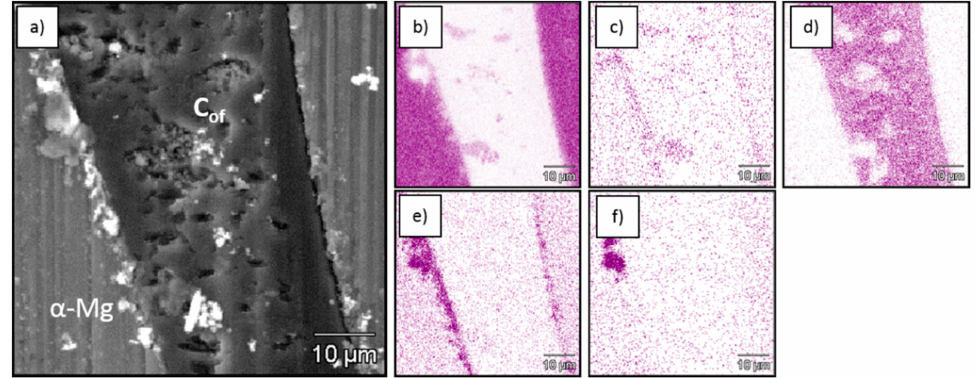
Figure 3. SEM micrograph of C of 45ppi–AZ31 composite ( a ) and EDS mapping of, ( b ) Mg, ( c ) O, ( d ) C, ( e ) Al and ( f )